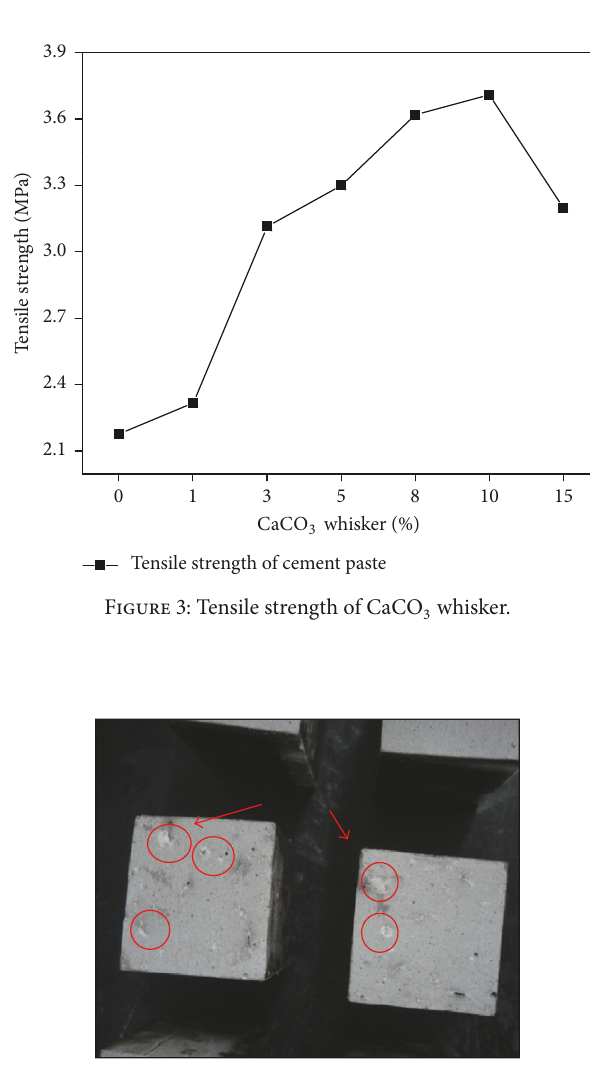
Figure 4: The failure surface of test-piece reinforced cement